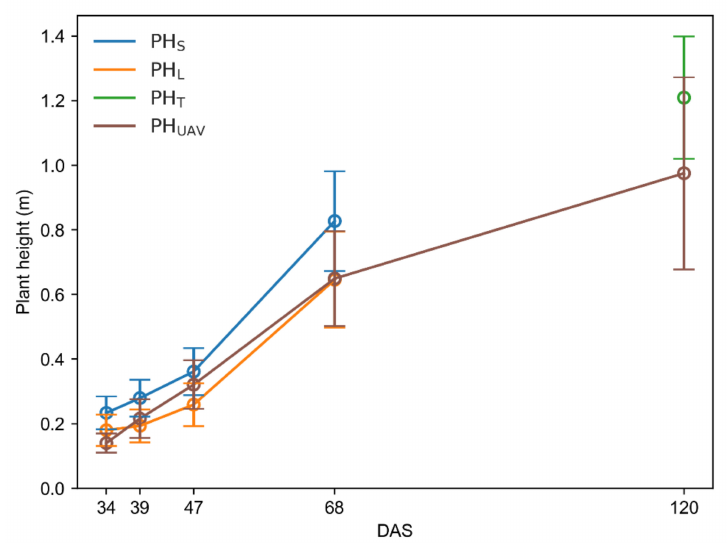
Figure 4. Average plant height of all plots during the growth period manually measured as distance to highest leaf (PH L ), highest straightened leaf (PH S ) and tassel tip (PH T ) as well as UAV-based estimated plant height (PH UAV ). Standard deviations are shown as error bars; DAS: days after sowing.